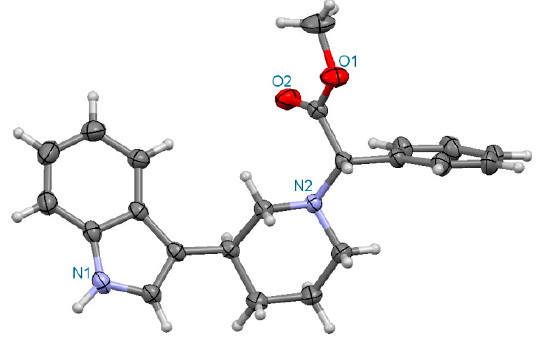
Figure 7. Perspective drawing of the molecule (3S,2S)-3a. Numbering system, which was used in NMR spectra interpretation of compounds (3R,2R)-4a , (3S,2R) - 5a , (3R,2R) - 6b , (3S,2R) - 7b , (3R,2R) - 8c and (3S,2R) - 9c is shown in Figure 8.